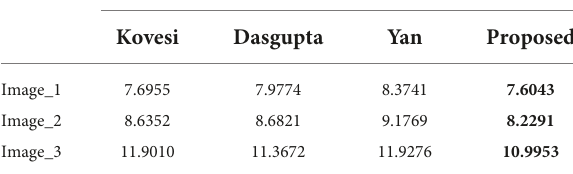
TABLE 4 The evaluation metric E of the tested images under different segmentation